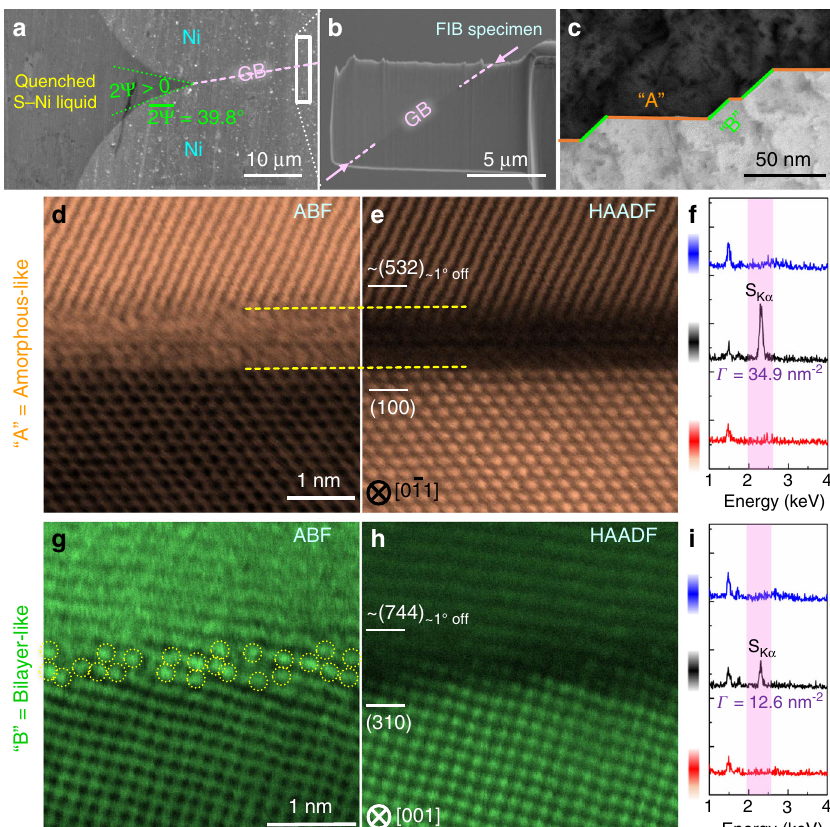
Fig. 2 A representative general (randomly selected asymmetric high angle) grain boundary (GB) in S-doped Ni with coexisting Type A and B facets. a Scanning electron micrograph of an Ni – S liquid interacting a GB with a non-zero dihedral angle in a specimen quenched from an equilibrium at 675 °C. b A TEM specimen containing a GB extracted by focused ion beam. c A low-magni fi cation STEM image showing the alternating Type A and B facets. A pair of synchronized ( d ) annular bright fi eld (ABF) and ( e ) high-angle annular dark fi eld (HAADF) images, along with ( f ) the corresponding EDX spectra, of a representative Type A amorphous-like facet (out of eight independent Type A facets examined along this same GB; see others in Supplementary Figs. 2 and 17). The excess adsorption of S measured by box scanning to be: Г = 34.9 nm − 2 . A pair of synchronized ( g ) ABF and ( h ) HAADF images, along